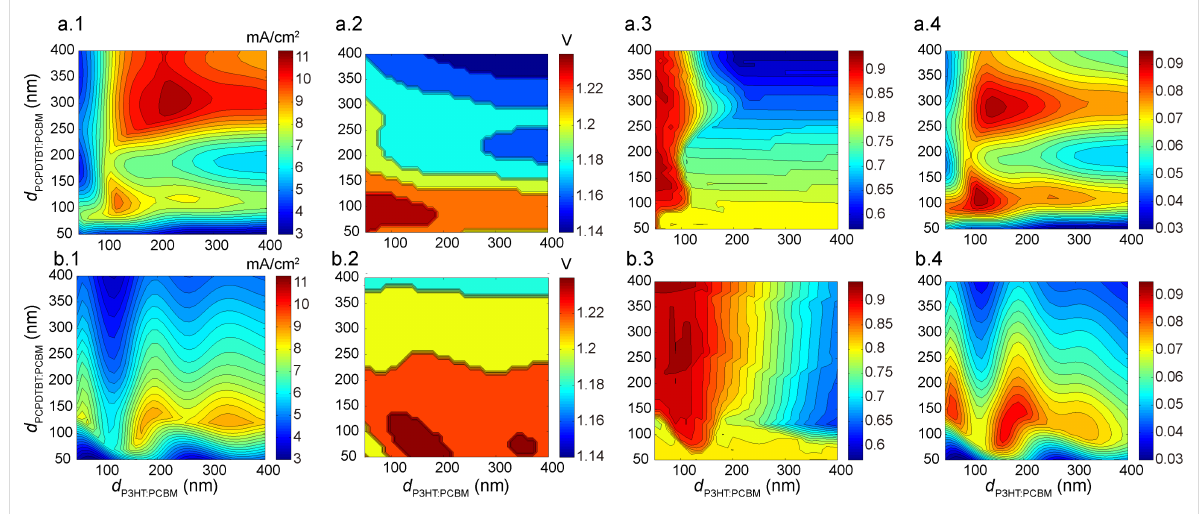
Figure 8: Device performance calculated through the multiscale simulation for configuration A (a) and B (b). a.1 and b.1 show J sc with respect to thickness. a.2 and b.2 present V oc . FF is given in a.3 and b.3. PCE is presented in a.4 and b.4. Here, the weight ratios for P3HT/PCBM and PCPDTBT/PCBM are 1:1 and 1:2, respectively.